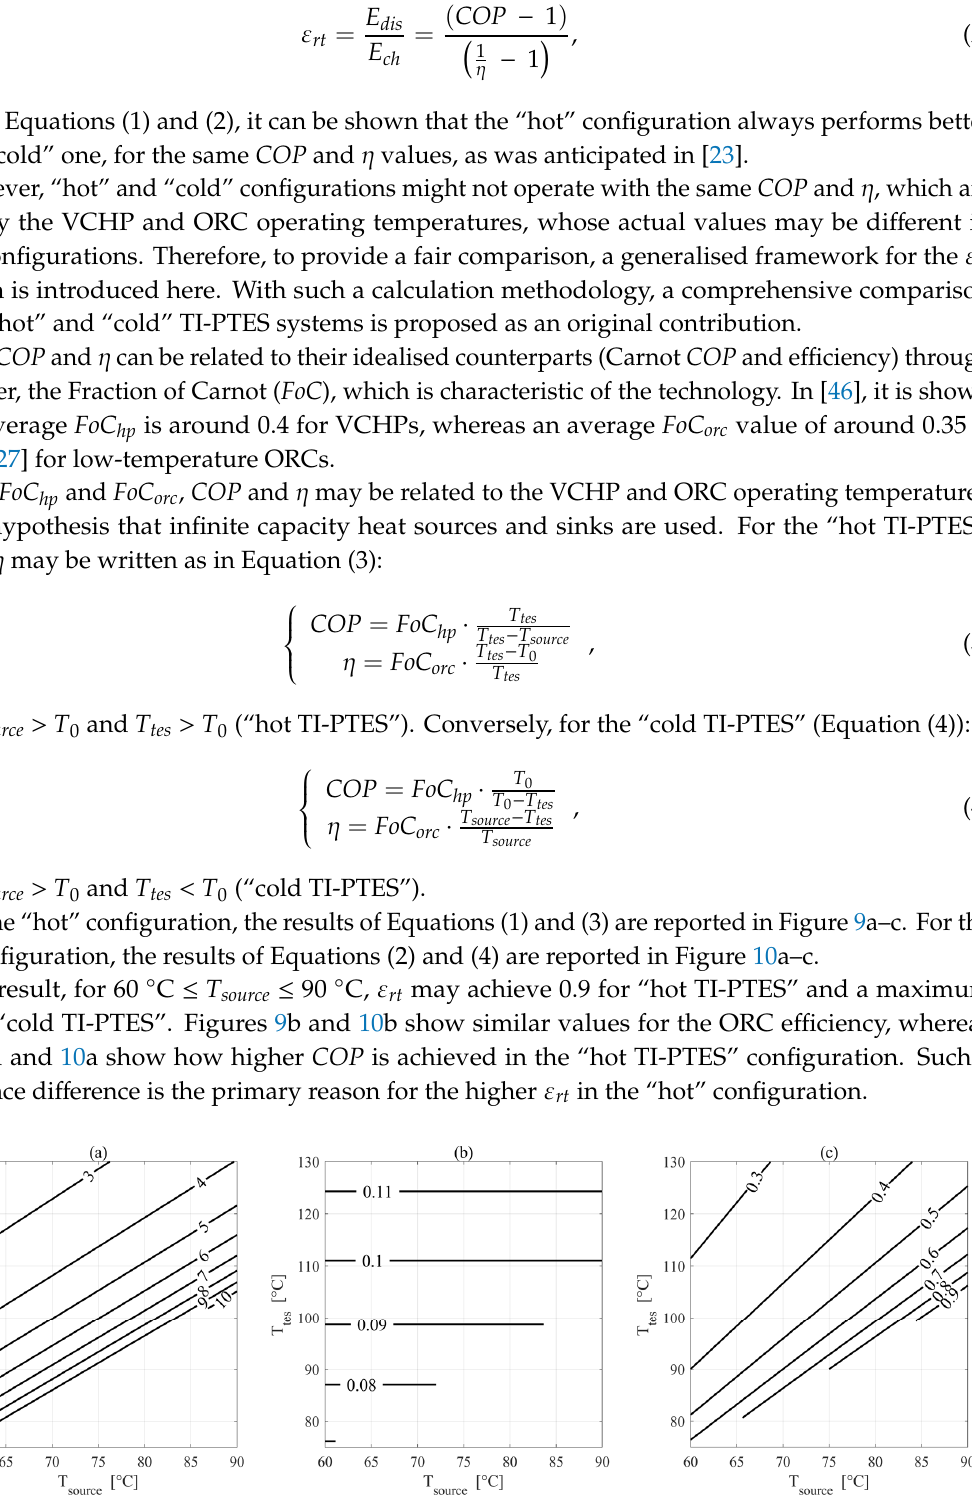
Figure 10. “Cold TI-PTES” performance parameters in terms of heat source temperature T source and TES temperature T tes . ( a ) VCHP COP ; ( b ) ORC η ; ( c ) TI-PTES ε rt . 4.2. Ratio between Thermal and Electric Inputs TI-PTES technologies have several positive features, which make them attractive from an industry point of view. However, the technology has also some shortcomings and technical challenges that should be addressed to make TI-PTES systems genuinely appealing in practice. From Figures 9 and 10, it can be understood how attractive roundtrip efficiencies, i.e., 0.6 ≤ ε rt ≤ 0.7, may be achieved for VCHP COP values equal to or higher than 6–7, and ORC η values between 0.07 and 0.1. Given the standard COP and η definitions for HPs and HEs, for the “hot TI-PTES”, the ratio between the electric input and the heat flow from the thermal source can be written as in Equation (5): (cid:3006) (cid:3278)(cid:3283) (cid:3018) (cid:3294)(cid:3290)(cid:3296)(cid:3293)(cid:3278)(cid:3280) = (cid:3024)(cid:4662) (cid:3278)(cid:3283) (cid:3018)(cid:4662) (cid:3294)(cid:3290)(cid:3296)(cid:3293)(cid:3278)(cid:3280) = (cid:2869) (cid:3004)(cid:3016)(cid:3017)(cid:2879)(cid:2869) ,